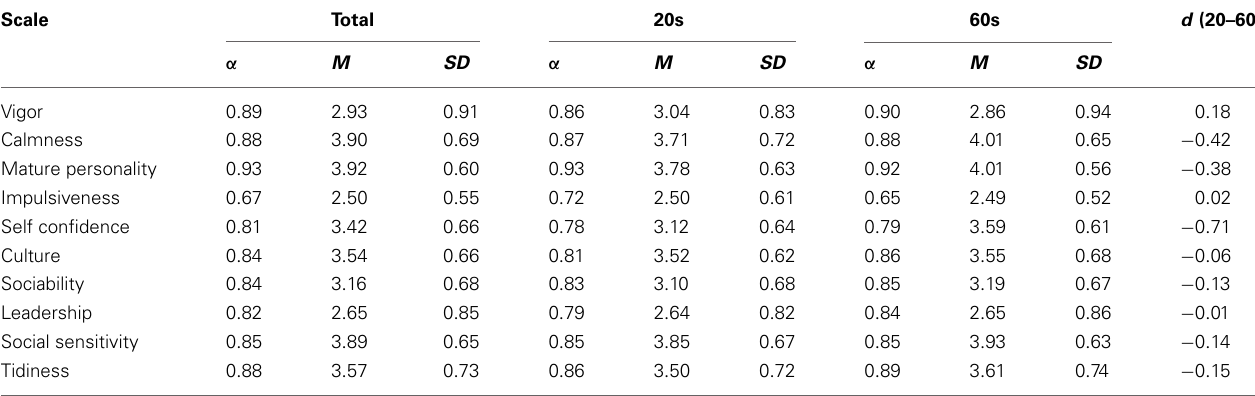
Table 1 | Reliabilities, means, and standard deviations in the Project Talent Personality Inventory Scales broken down by age. Scale